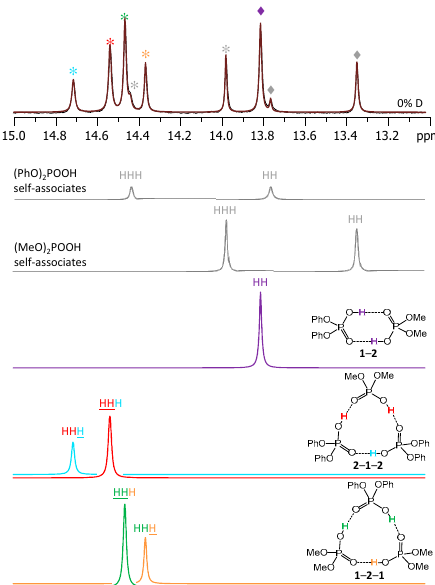
Figure 3. The low-field part of the 1 H - NMR spectrum of the sample containing acids 1 and 2 (1:1) in CDF 3 /CDF 2 Cl at 100 K. The experimental spectrum is deconvoluted into the sub-spectra arising from self-associated of 1 or 2 , heterodimer 1 - 2, and two heterotrimers, 1 - 2 - 1 and 2 - 1 - 2 . For visual clarification the signals in the experimental spectrum and the computed sub-spectra are color coded. Trimers and dimers are marked by asterisks and diamonds, respectively.